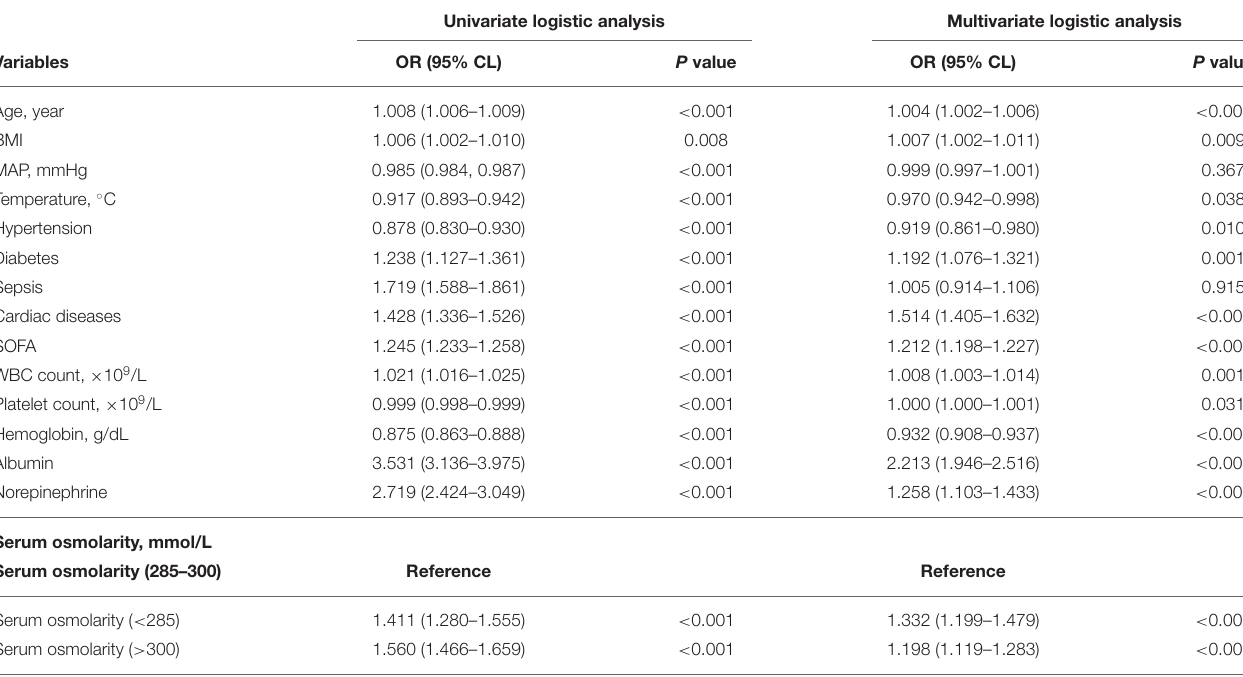
TABLE 2 | Univariate and multivariate logistic regression analyses for